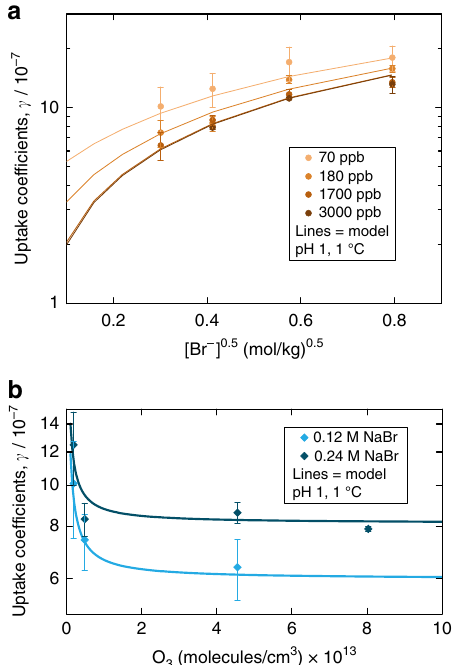
Fig. 1 Heterogeneous kinetics results. Measured uptake coef fi cients of ozone, γ obs , at different ozone concentrations ( symbols ) on aqueous bromide solutions, along with calculated uptake coef fi cients ( lines ) from a parameterized fi t to several measured datasets, explained in Supplementary Notes 1 and 2. The uptake coef fi cient is the loss rate of gas phase ozone to the aqueous solution normalized to the gas kinetic collision rate with the aqueous solution surface. In plot a , data from experiments performed with solutions of varying bromide content are shown for four different ozone concentrations in the gas phase, while in plot b , data result from experiments, in which the ozone concentration was varied, for two different bromide concentrations in the aqueous phase. Error bars represent s.d. of